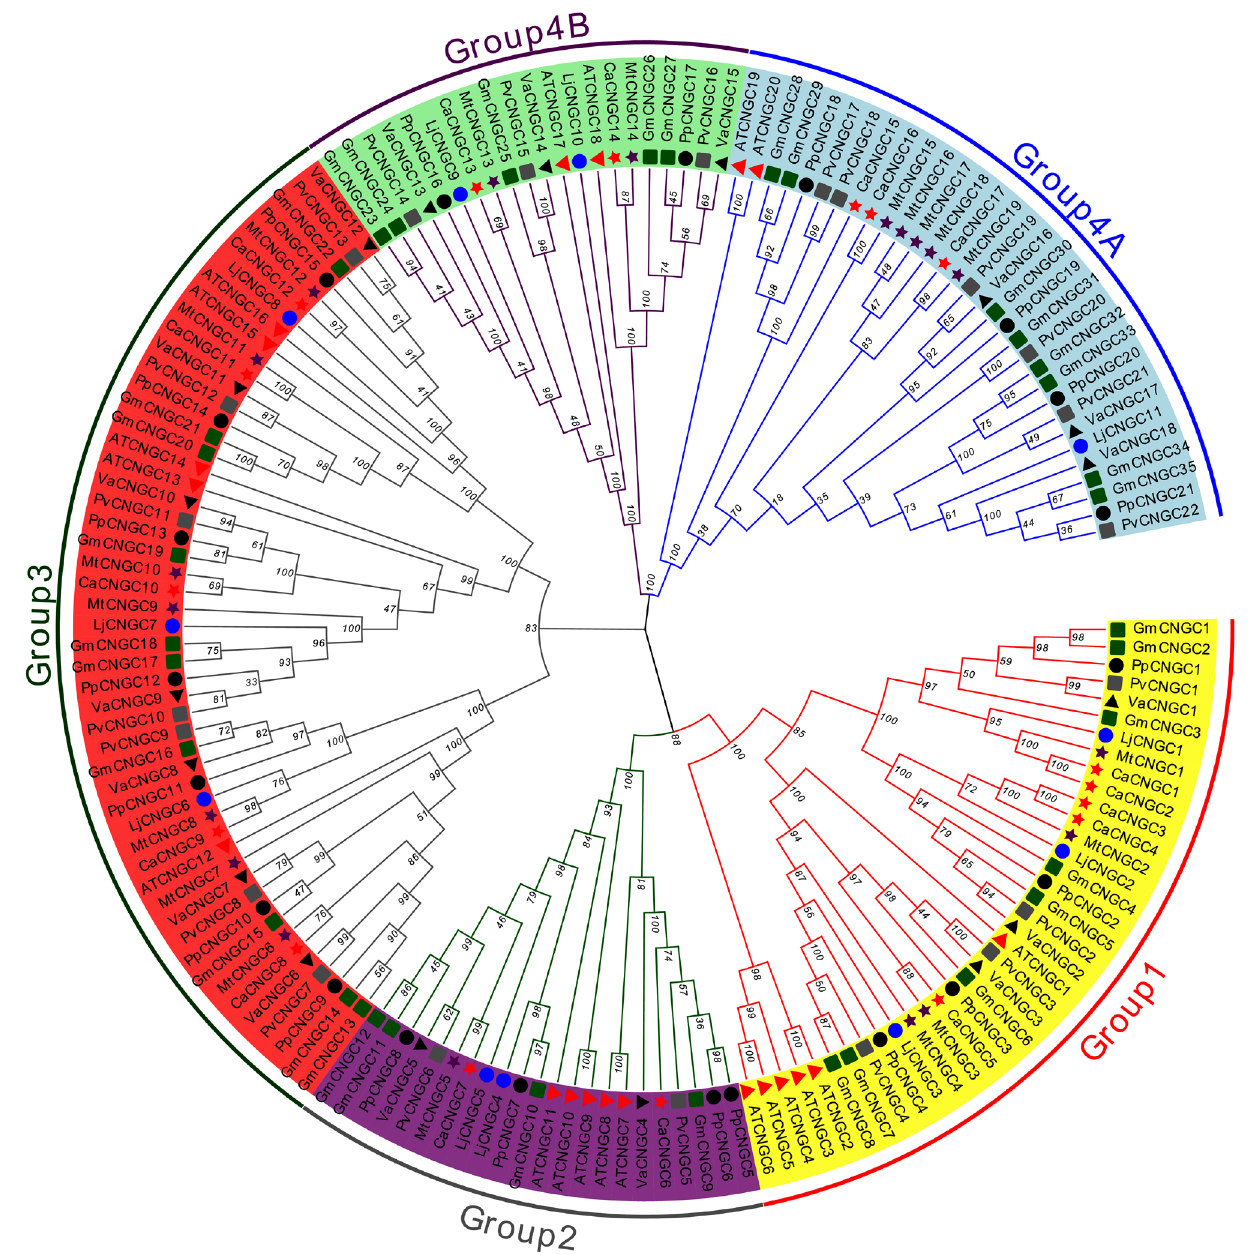
Figure 1. Systematic evolutionary relationships within the CNGC gene family (AtCNGC, GmCNGC, MtCNGC, CaCNGC, PpCNGC, LjCNGC, VaCNGC, and PvCNGC refer to the gene families of A. thaliana , G. max , M. truncatula , C. arietinum , C. cajan (pigeon pea), L. japonicus , V. angularis ,